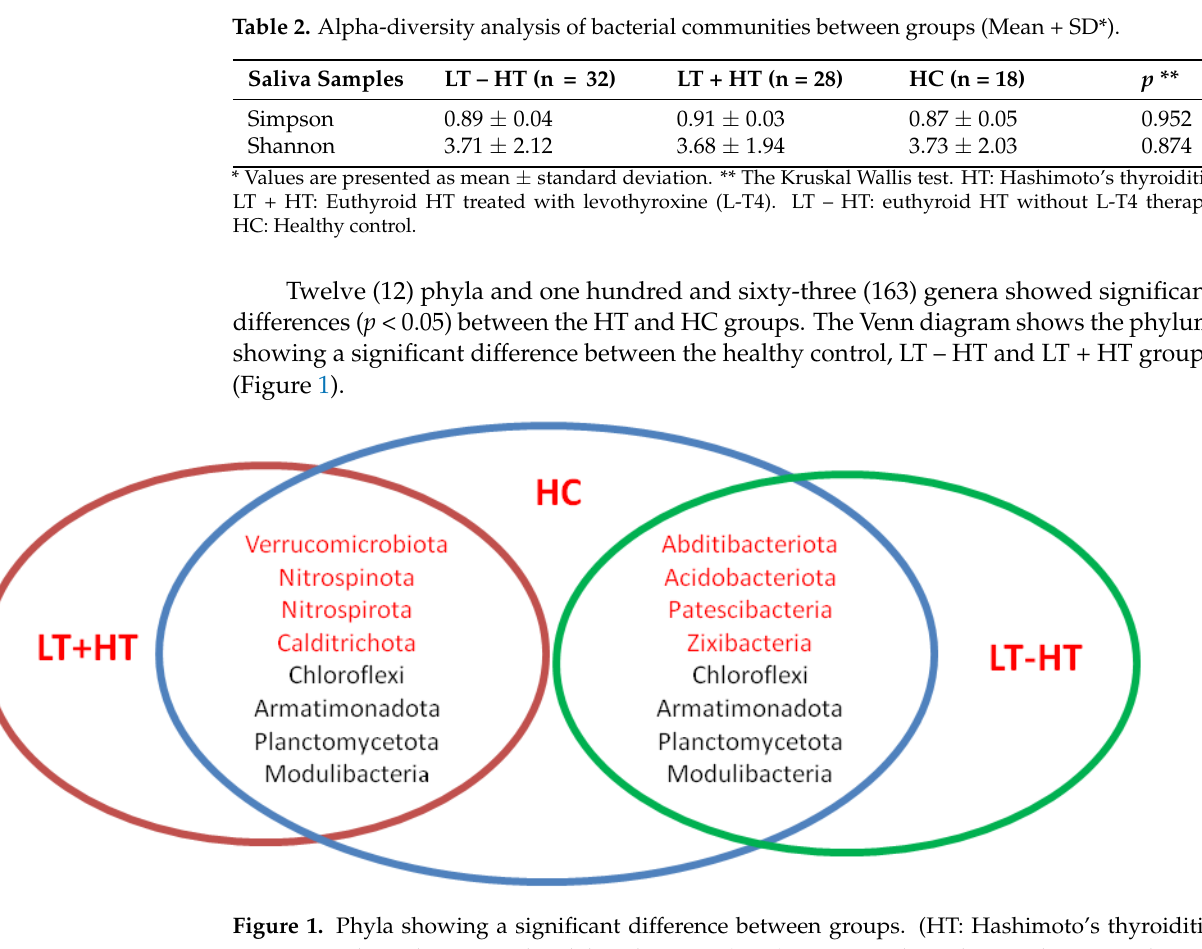
Figure 1. Phyla showing a significant difference between groups. (HT: Hashimoto’s thyroiditis. LT + HT: Euthyroid HT treated with levothyroxine (L-T4). LT-HT: euthyroid HT without L-T4 therapy. HC: Healthy control).